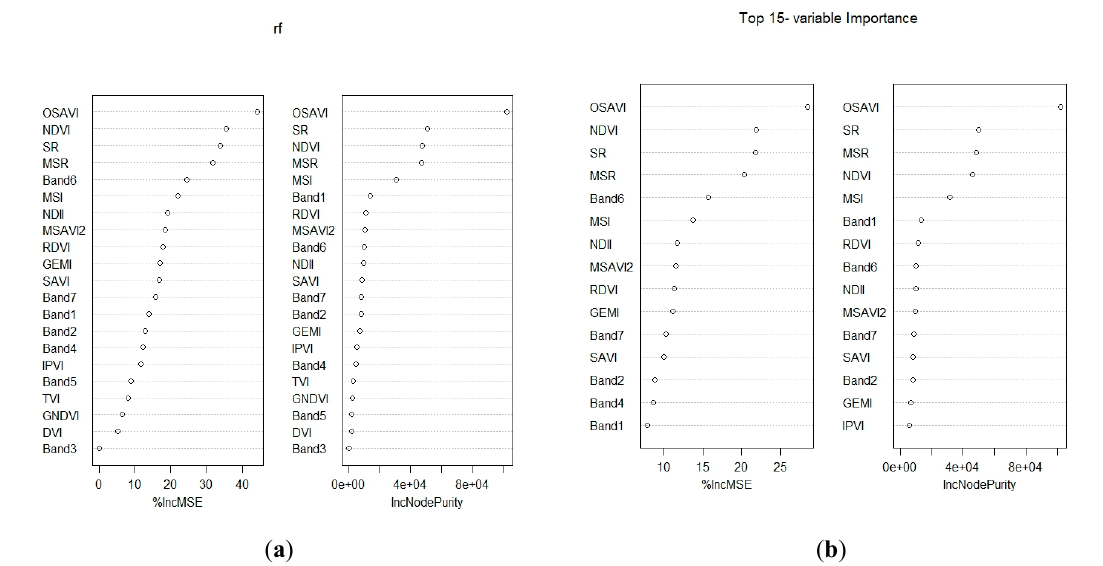
Figure 5. ( a ) Important variable ranking by Random forest algorithm and ( b ) top 15 selected important variables.